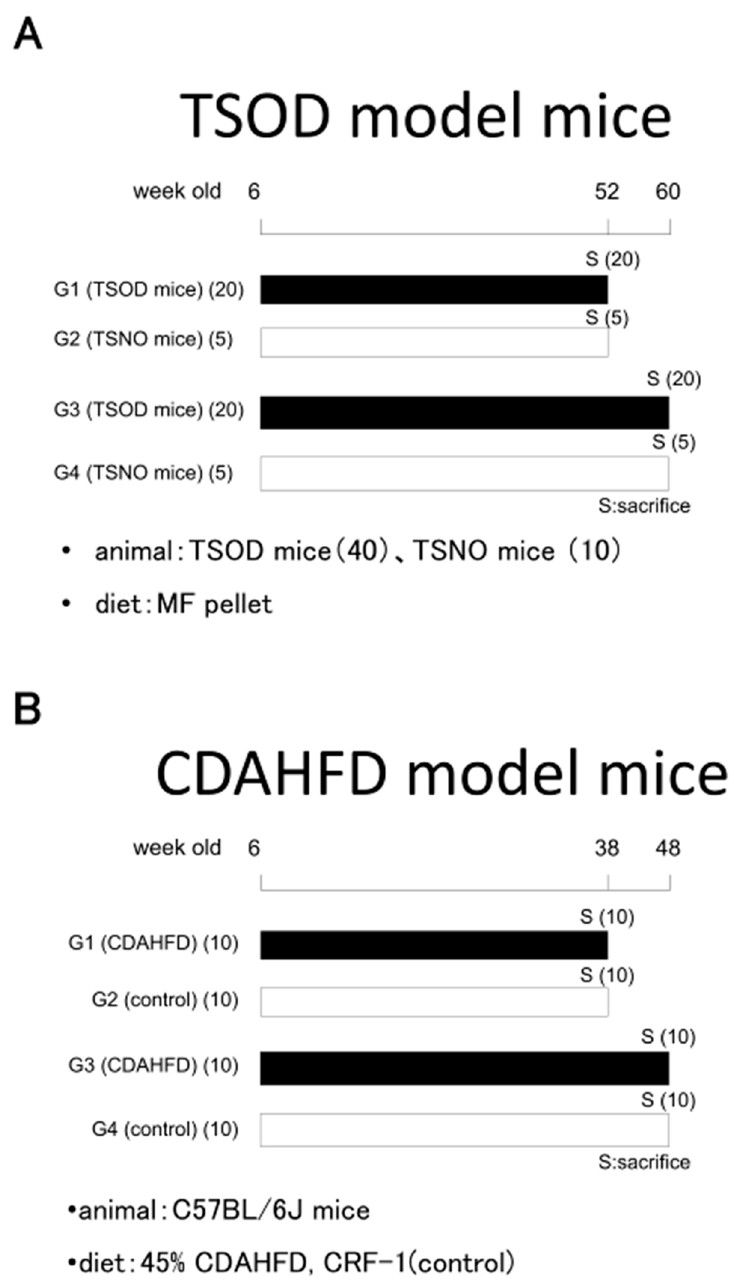
Figure 4. Experimental protocols. ( A ) TSOD NASH model mice with metabolic syndrome; ( B ) NASH model C57Bl/6J mice administered 45% CDAHFD.